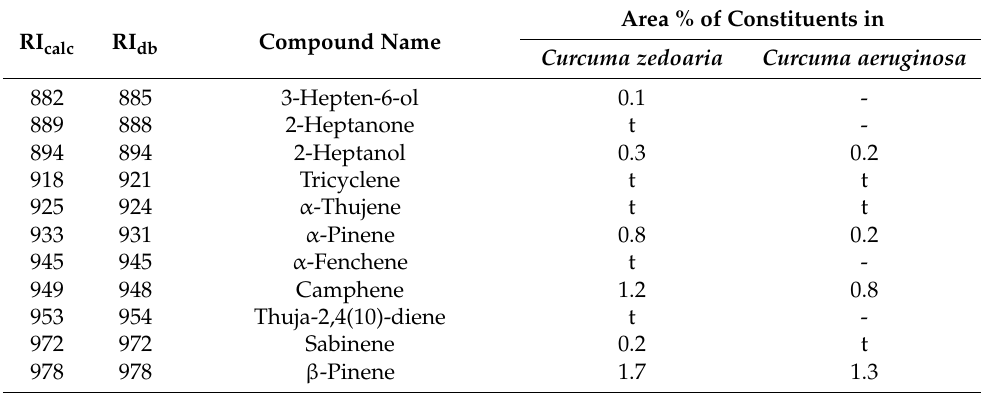
Table 2. Individual constituents of Curcuma aeruginosa and Curcuma zedoaria essential oil. RI calc RI db Compound